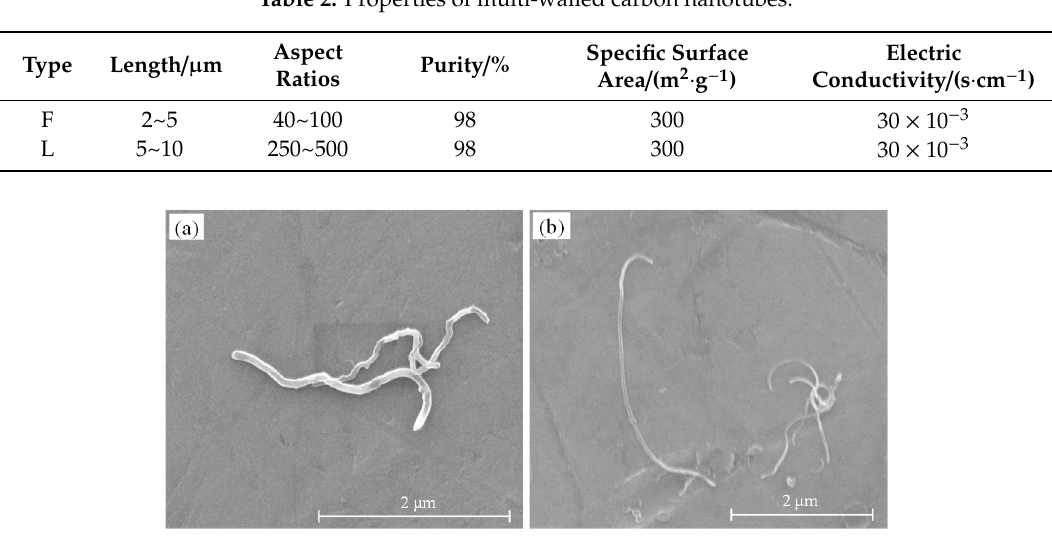
Figure1. ScanningelectronmicroscopeimageoftypeF( a )andtypeL( b Figure 1. Scanning electron microscope image of type F ( a ) and type L ( b ) multi-walled carbon nanotubes. Table 2. Properties of multi-walled carbon nanotubes.